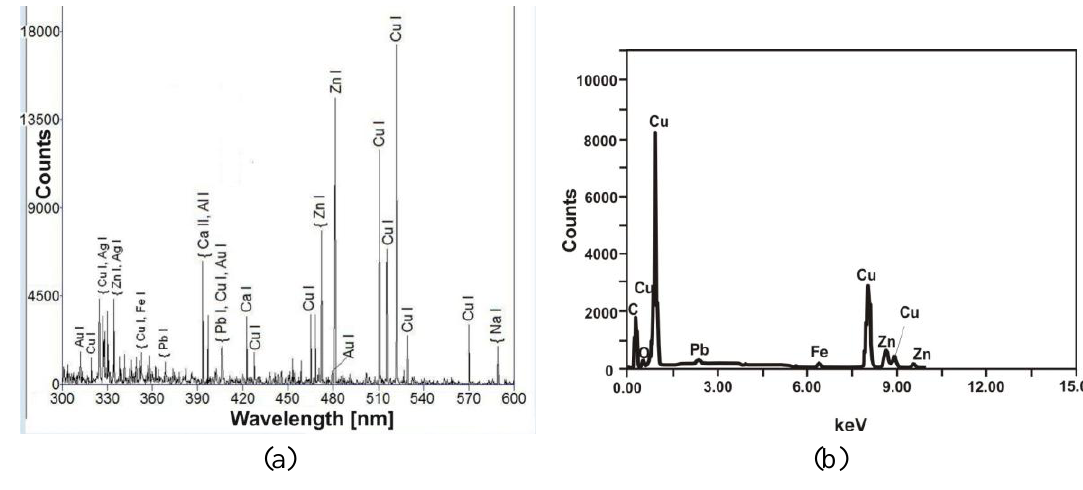
Figure 12. Putto with laurel substrate alloy: (a) LIBS spectrum; (b) EDS spectrum.